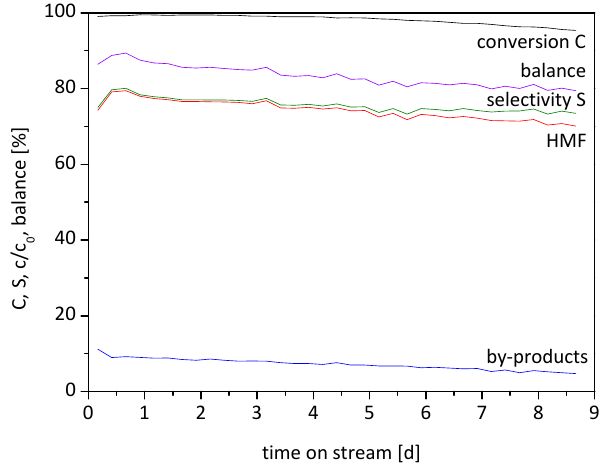
Figure 5. Long-term stability of the fixed bed ( τ = 80 min (0.162 mL/min), 0.1 M Fructose, 95 °C, 17.5 vol% H 2 O in HFIP, 1.7 g Lewatit K2420 catalyst bed).